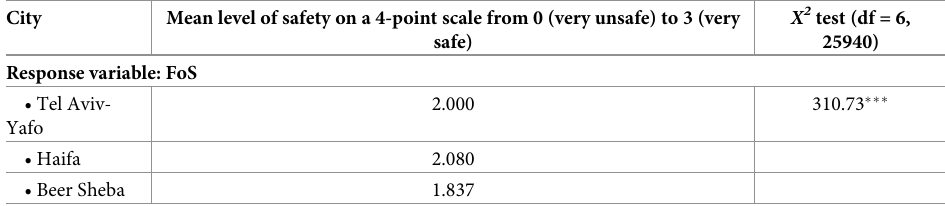
Table 2. X 2 -test of differences in the observed values of FoS across the cities surveyed (method: Pearson’s X 2 test). City Mean level of safety on a 4-point scale from 0 (very unsafe) to 3 (very safe)